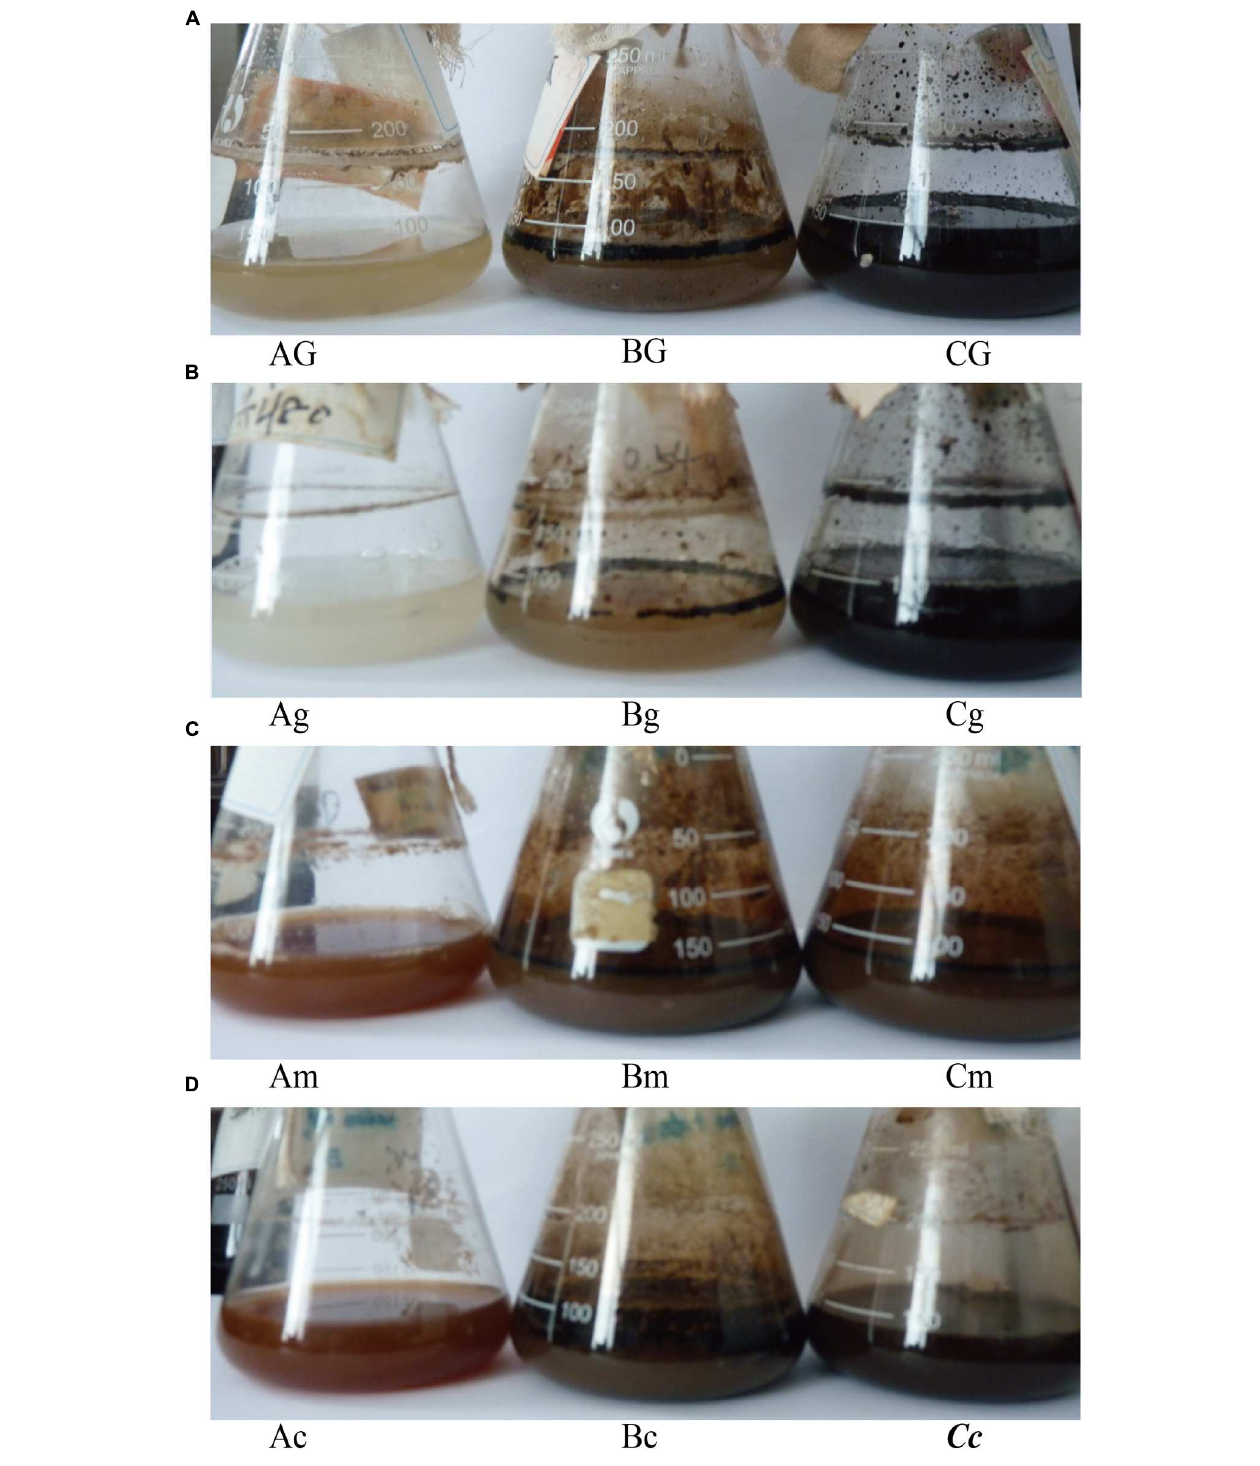
FIGURE 5 | Oil emulsification during stimulation with nutrients or in combination with Bacillus subtilis M15-10-1. Different combinations are presented in images (A–D) . A: microcosm containing nutrients; B: microcosm containing nutrients and crude oil; C: microcosm containing nutrients, crude oil, and Bacillus subtilis M15-10-1; G: glucose; g: glycerol; m: molasses; and c: corn steep powder.